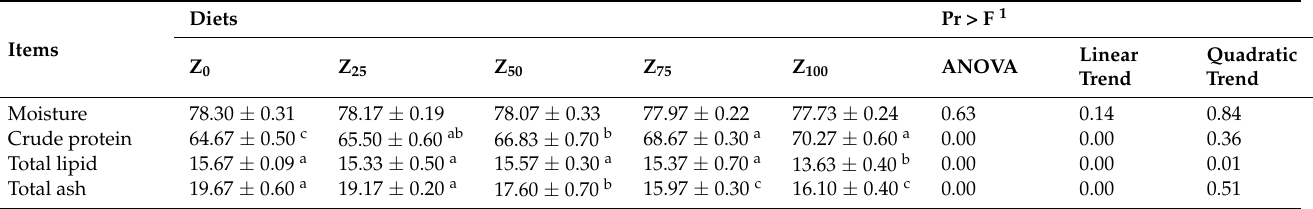
Table 5. The approximate composition (% on dry matter basis) of whole-body of grey mullet, Mugil cephalus , fed experimental diets for 60